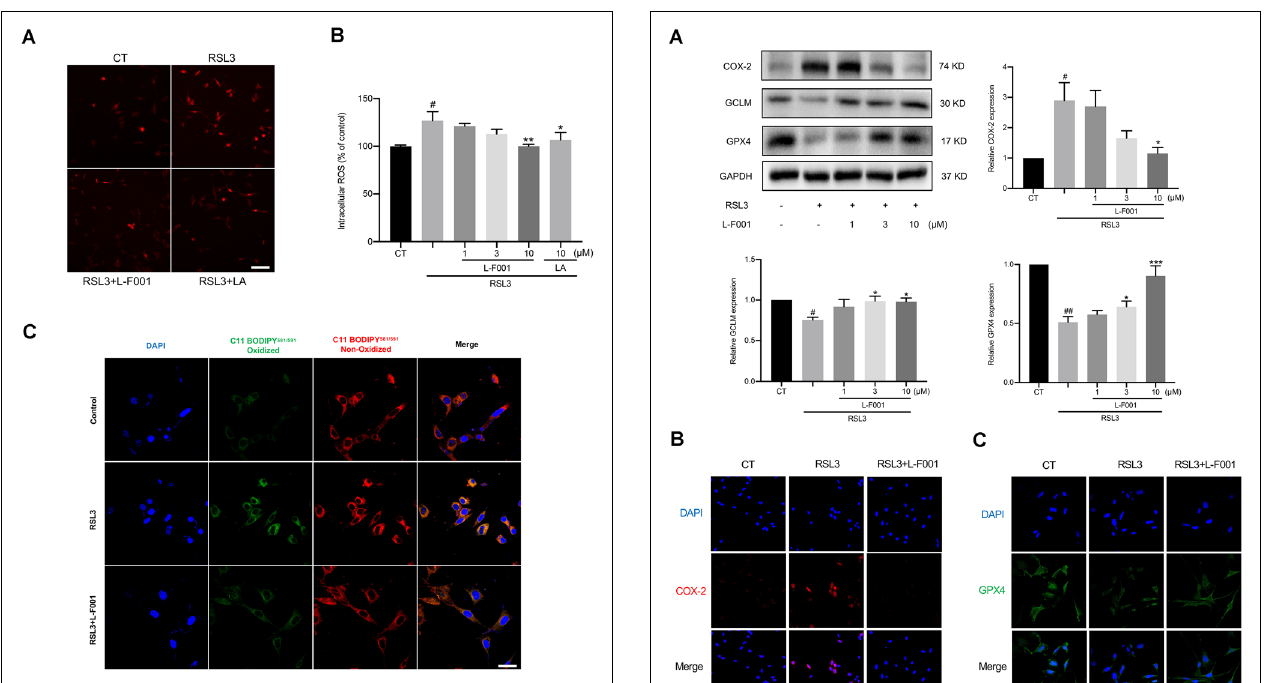
FIGURE 2 | L-F001 reduces RSL3-induced ROS production and lipid peroxidation in HT22 cells. (A) HT22 cells were treated with 0.1 µ M RSL3 alone, and then added L-F001 (1–10 µ M) and LA (10 µ M) at 37 ◦ C for 24 h. ROS formation was measured with a fluorescence microscope (scale bar = 50 µ m). (B) ROS levels were measured with a fluorescence plate reader ( n = 3). (C) The lipid ROS formation was monitored by a laser confocal microscope using a C11-BODIPY581/591 probe (Scale bar = 25 µ m). # P < 0.05 compared with the control group. * P < 0.05, ** P < 0.01 compared with the RSL3-induced group.